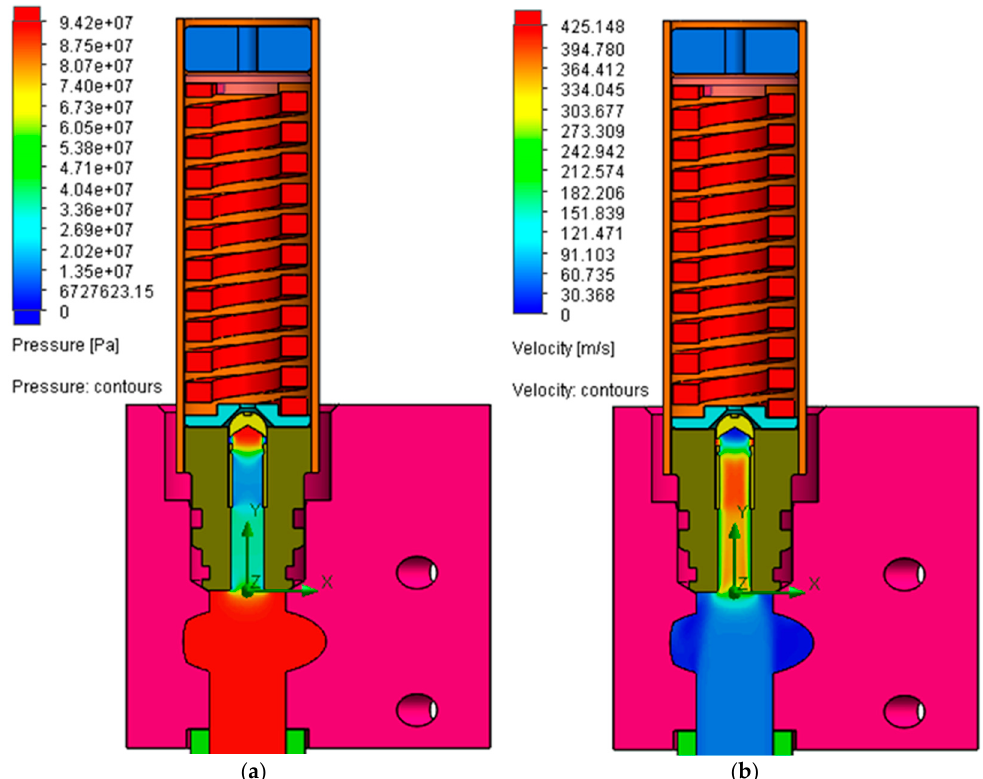
Figure 19. The variation maps of pressure ( p ) ( a ) and velocity ( υ ) ( b ) for a 0.01335 m 3 · s − 1 volume flow rate (800 L · min − 1 ).